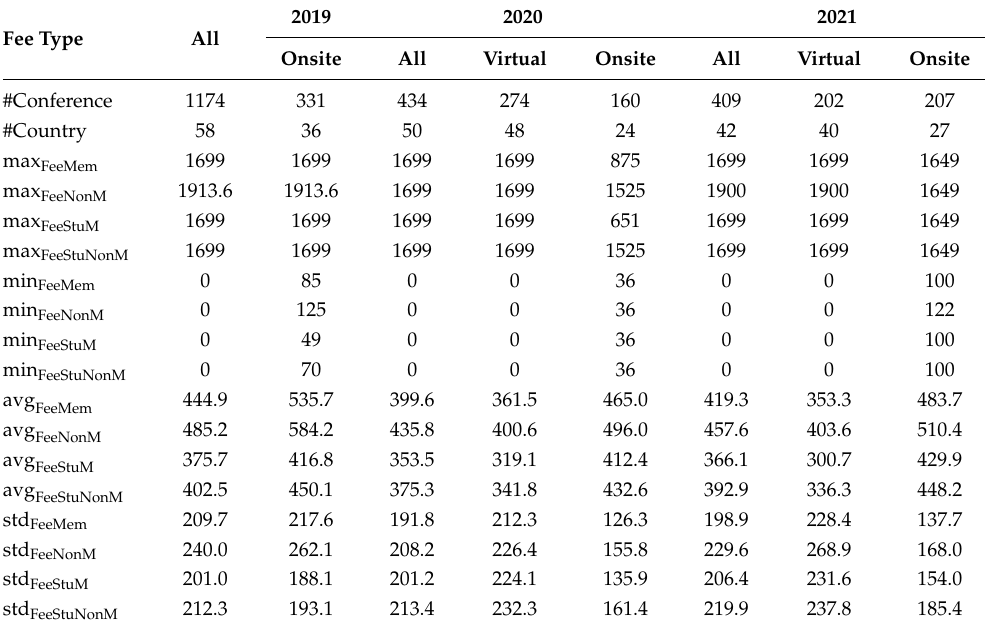
Table A5. Basic statistics of the conference data after data